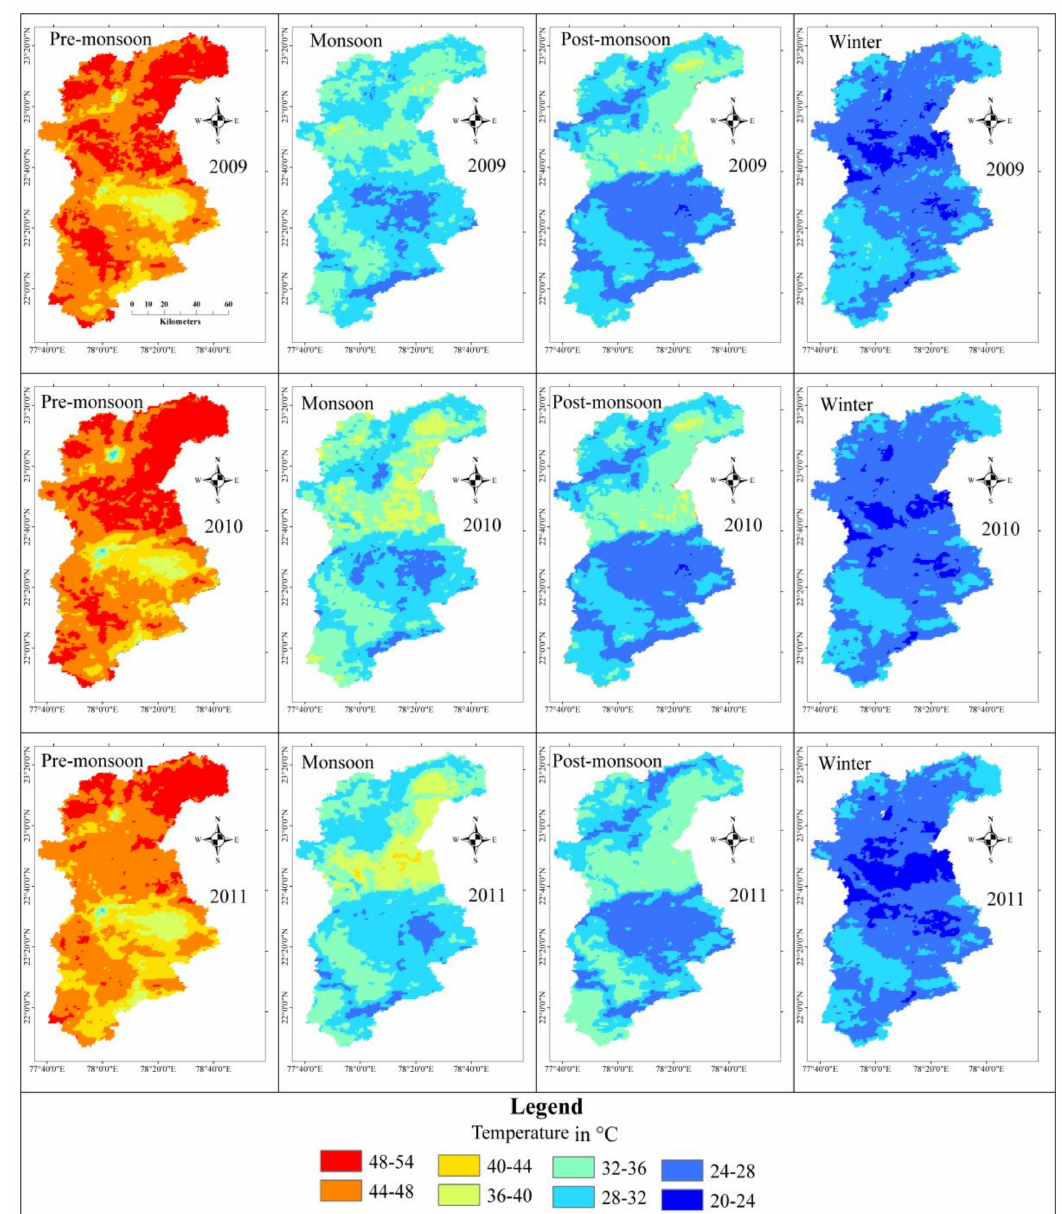
Figure 3. Seasonal land surface temperature (LST) for 2009, 2010, and